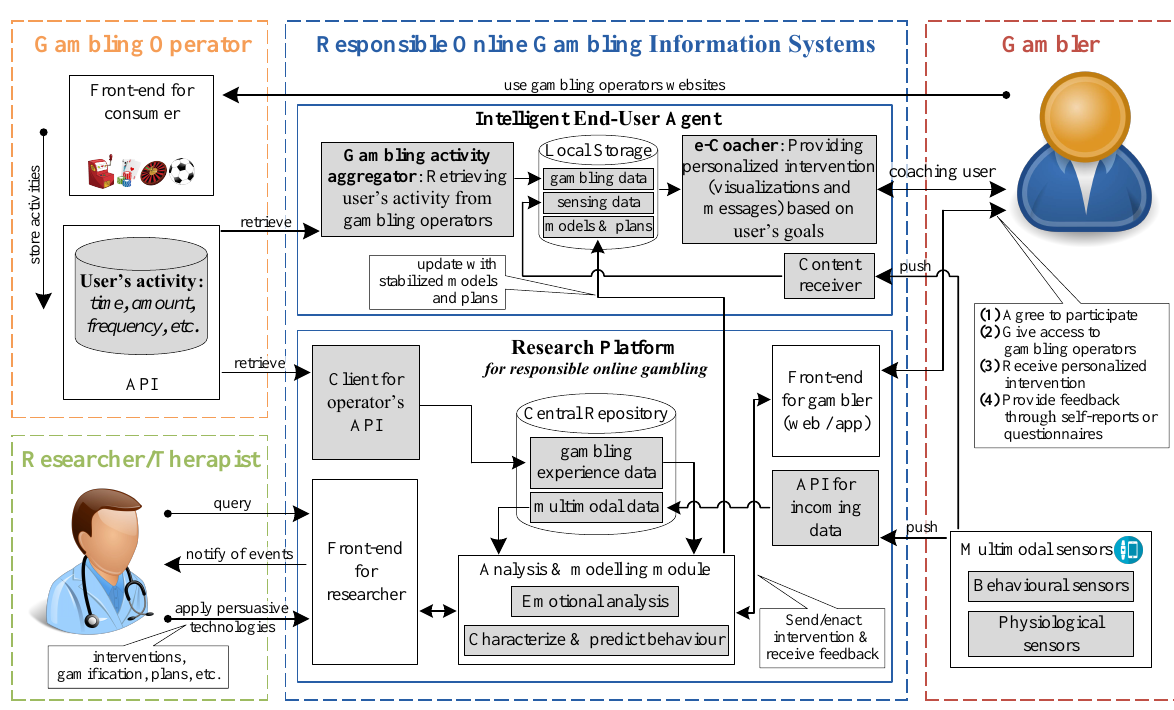
Figure 3. The conceptual architecture for persuasive responsible gambling information